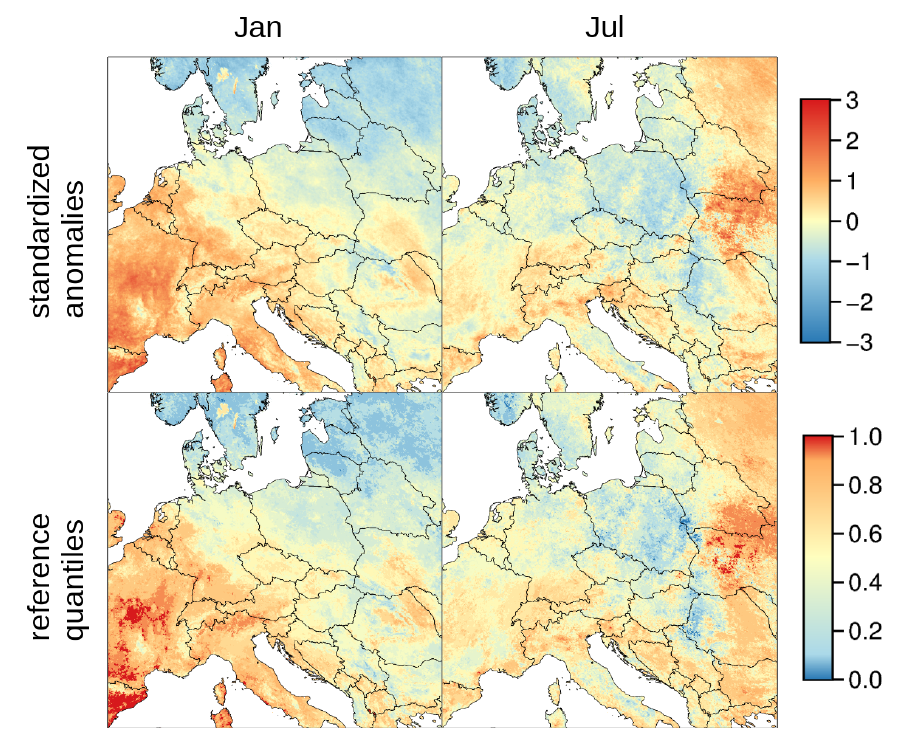
Figure 11. Comparison of January and July 2016 LST to the reference time series given as numbers of standard deviations from the long term average (intensity) and as corresponding quantiles of the reference time series